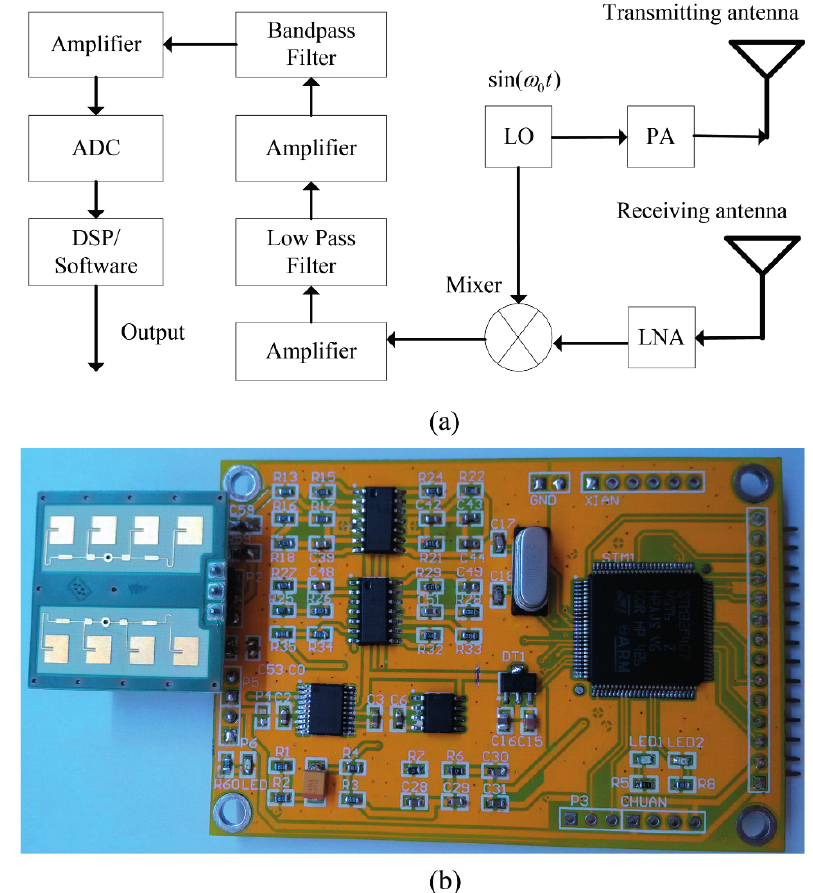
Figure 1. CW radar sensor system. ( a ) Block diagram of the 24 GHz radar respiration sensor system; ( b ) Photograph of the 24 GHz respiration radar sensor